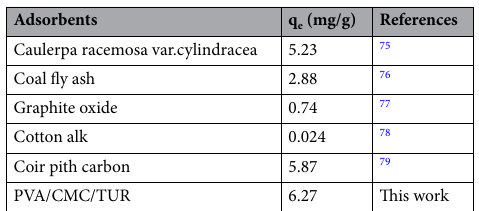
Table 12. Comparison studies of previous work on MB dye on various